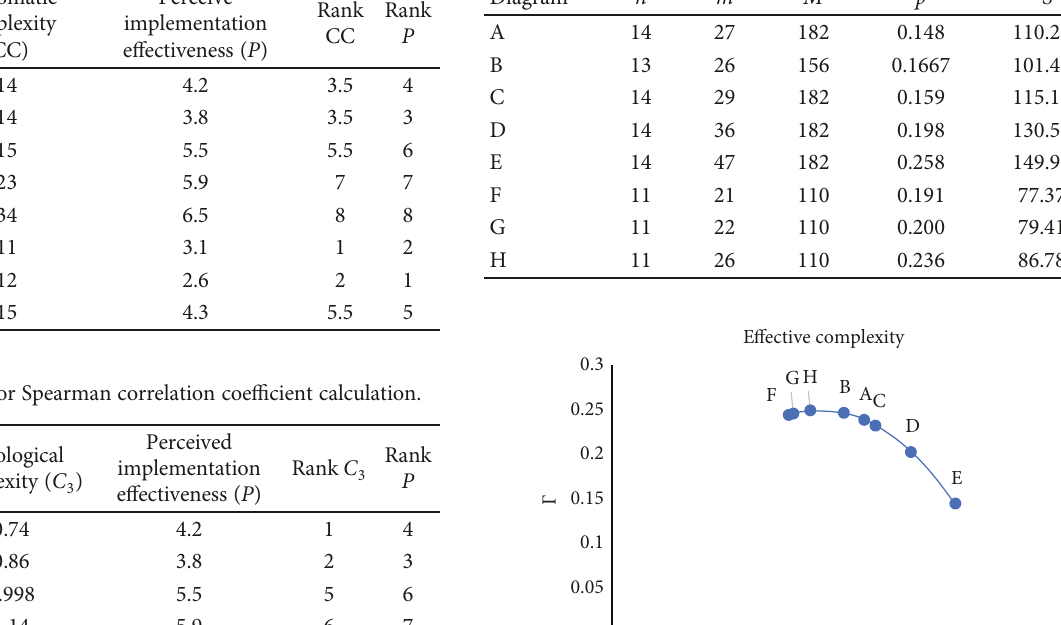
Table 6: Entropy calculation for each diagram. Diagram